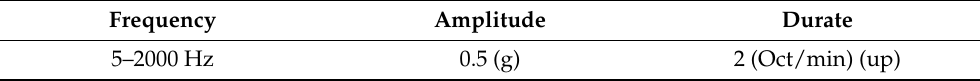
Table 2. Sine vibrations specifications.